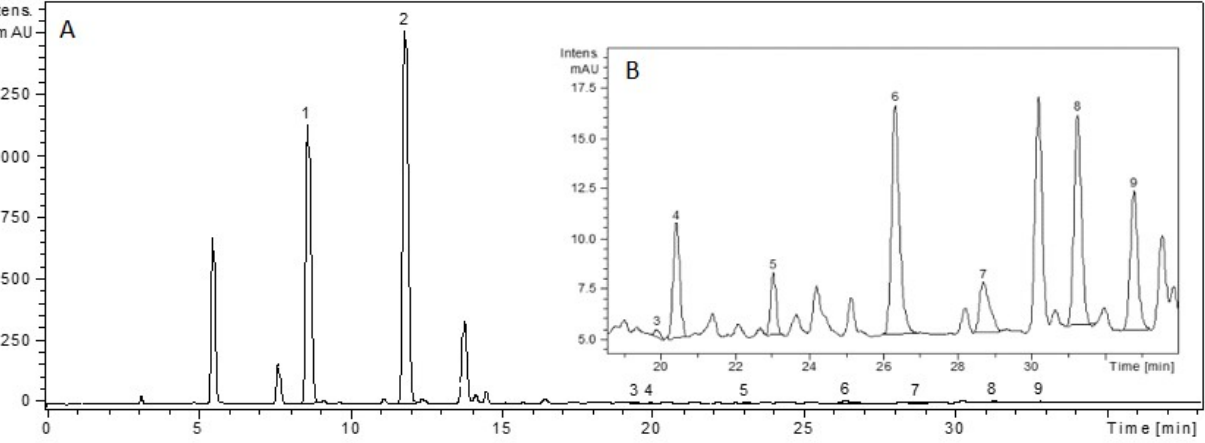
Figure 1. HPLC chromatogram of hydroalcoholic propolis extract. ( A ) Global view (1—p-coumaric acid, 2—ferulic acid). ( B ) Close-up of signal intensity of time range 19–34 min (3—isoquercitrin, 4—rutoside, 5—quercitrin, 6—quercetin, 7—luteolin, 8—kaempferol, 9—apigenol).